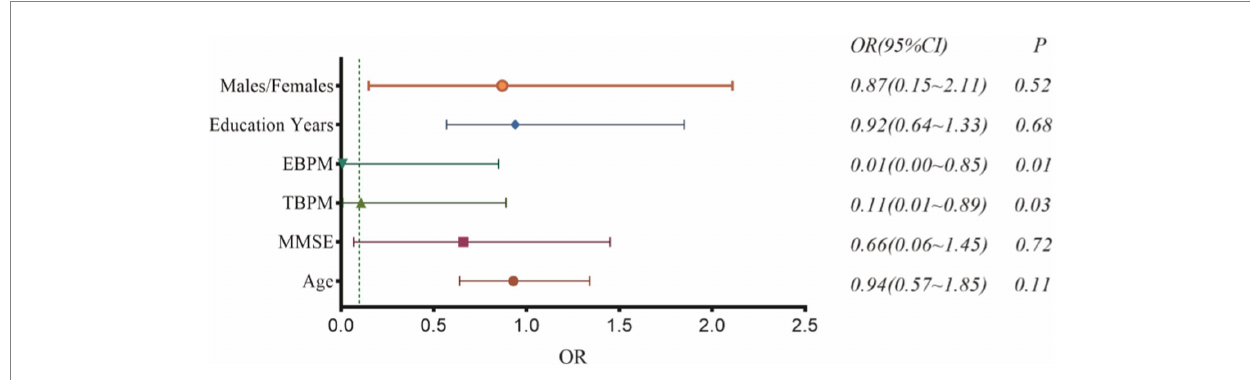
FIGURE 3 Independent predictors of WD cognitive